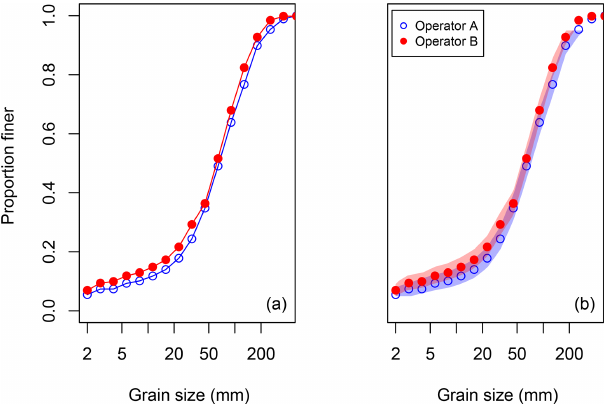
Figure 8. Comparing pebble counts of the same bed surface by dif- ferent operators. The data plotted were published by Bunte and Abt (2001a). Panel (a) shows the traditional grain size distribution rep- resentation. Panel (b) uses the 95% grain size confidence intervals calculated for the pebble count to demonstrate that the two distribu- tions are not statistically different.